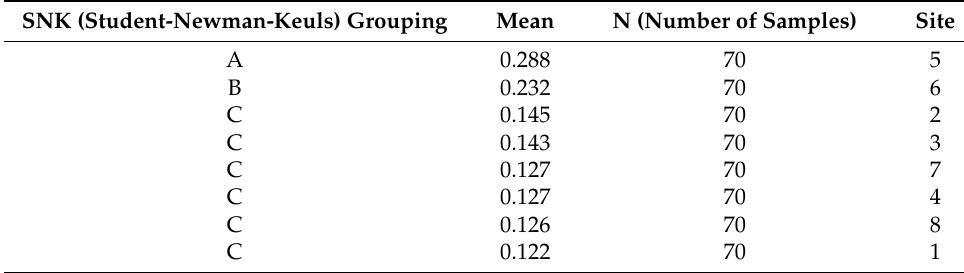
Table 4. Difference analysis in different